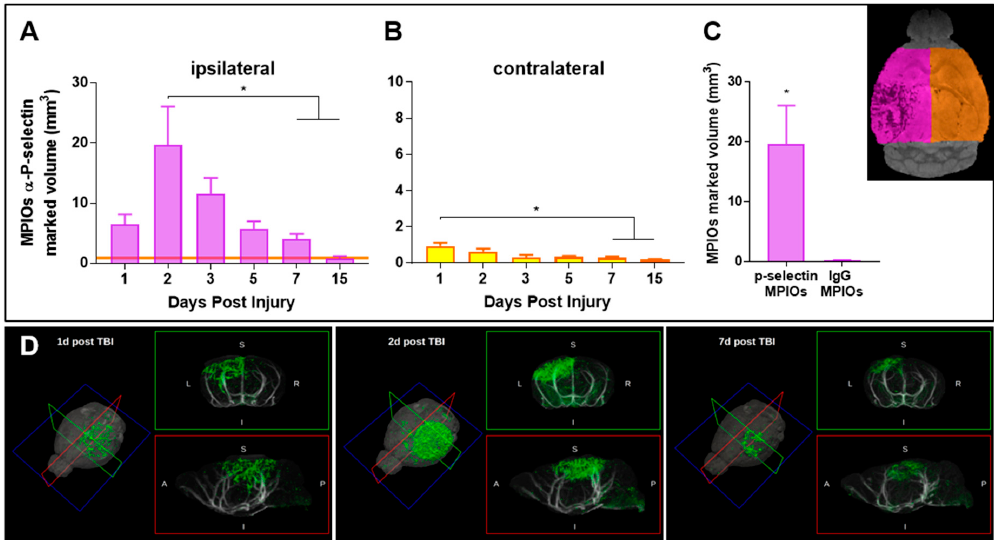
Figure 2. MPIOs- α -P-selectin quantification by MRI. The MPIOs- α -P-selectin marked volume (mm 3 ) was longitudinally assessed by MRI up to 15 days post-injury in both the ( A ) ipsilateral (purple, left) and ( B ) contralateral (yellow, right) hemispheres. The orange line in panel A indicates the mean contralateral MPIOs- α -P-selectin marked volume (0.9 mm 3 ). Data are mean + SEM, 3-4 / group. One-way ANOVA followed by Tukey post-hoc; ipsilateral hemisphere: 2 days vs. 7, 15 days * p < 0.05; contralateral hemisphere: 1 day vs. 7, 15 days * p < 0.05. ( C ) Hypointense volume (mm 3 ) assessed by MRI in ipsilateral hemisphere two days post-TBI in mice injected with MPIOs conjugated with either anti P-selectin or isotypic IgG antibodies. Data are mean + SEM, 3-4 / group; unpaired t -test, * p < 0.05 ( D ) Representative 3D reconstruction with coronal (upper) and sagittal (lower) cross-section of MPIOs- α -P-selectin marked volume (green) 1, 2 and 7 days post-TBI. Vasculature (in white) given by the angiography was co-registered to the T2* MRI images.